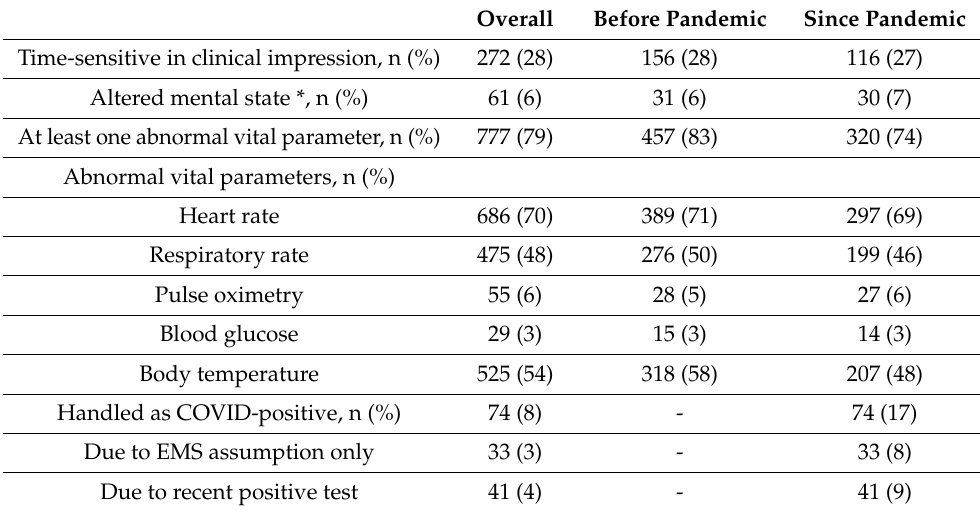
Table 4. Findings in primary survey, percentages rounded to integers, * Glasgow Coma Scale score below 15